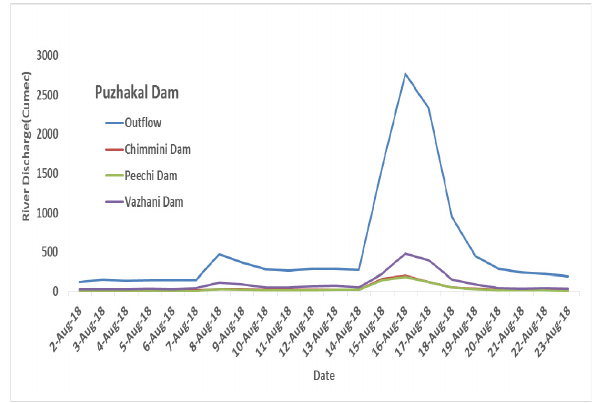
Figure 15b: Daily rainfall from IMD data for various sub- watersheds of Puzhakal river basin.